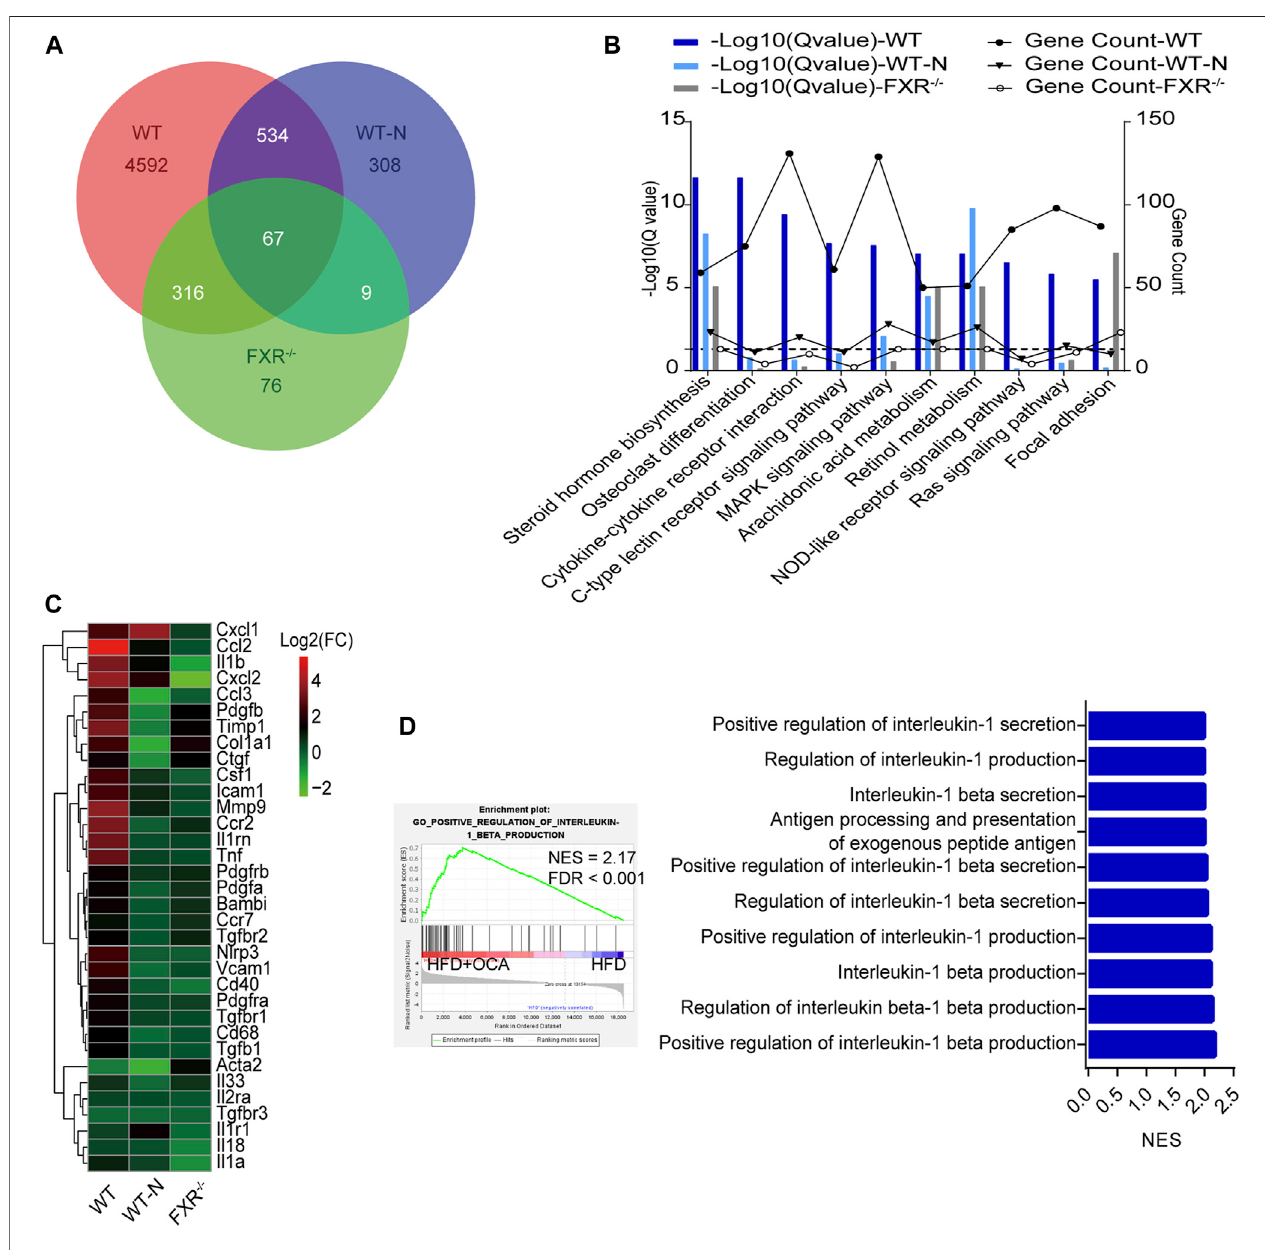
FIGURE 3 | High-dose OCA induced an FXR-mediated in fl ammatory response WT mice (WT group), and FXR − /- mice (FXR − /- group) fed with 0.16% OCA as describedin Figure2 ;andWTmicetreatedwith0.04%OCAfor76days(WT-Ngroup). (A) Differentiallyexpressedgenesofmice. (B) KyotoEncyclopediaofGenesand Genomes (KEGG) pathway analysisof differentially expressed genes, dashed horizontal lineis plotted at 1.3 ( Q -value = 0.05). (C) Proin fl ammatory mediator and fi brosis gene expression in livers of mice. (D) Gene Set Enrichment Analysis was performed to analyze the pathways enrichment in WT group. Left panel, the most signi fi cantly enriched gene sets. Right panel, representative 10 signi fi cantly enriched gene sets from GSEA analysis. ES, enrichment score; FDR, false discovery rate; FXR, farnesoid X receptor; OCA, obeticholic acid; NES, normalized enrichment score; ns, not signi fi cant; *, p ＜ 0.05; **, p ＜ 0.01; ***, p ＜ 0.001.